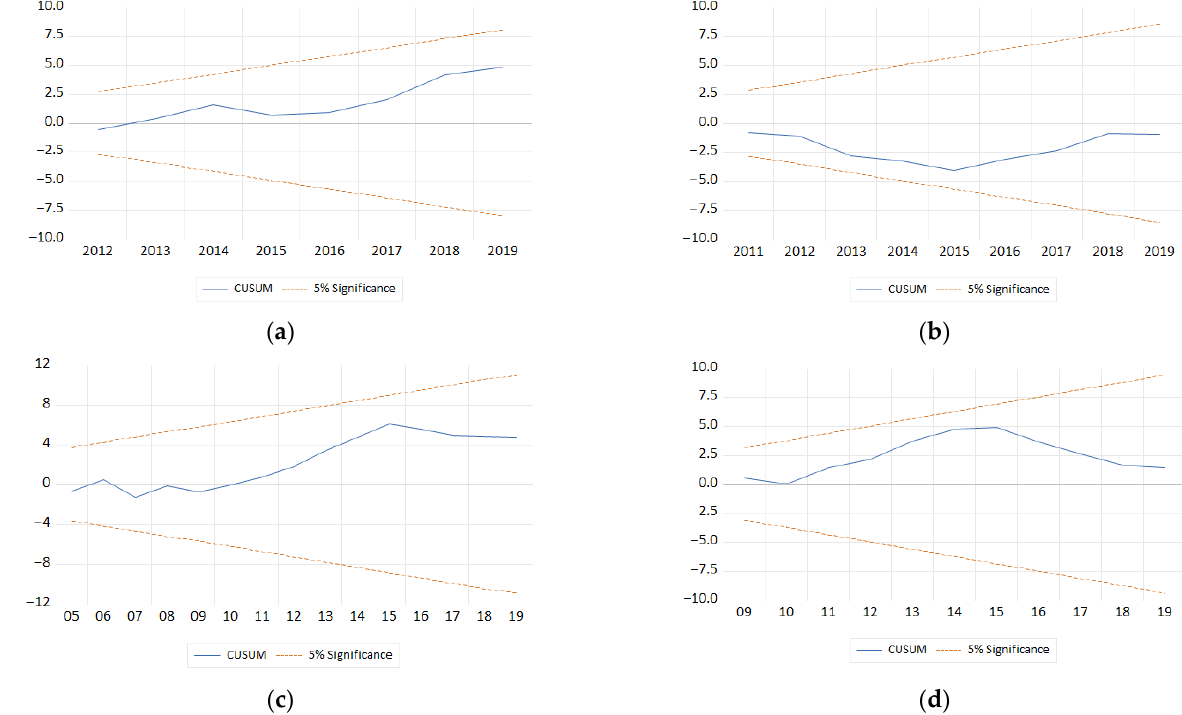
Figure A2. Hungary ( a ) Model 1 (dep. variable CO 2 ). ( b ) Model 2 (dep. variable EC). ( c ) Model 3 (dep. variable GDP). ( d ). Model 4 (dep. variable FRT).